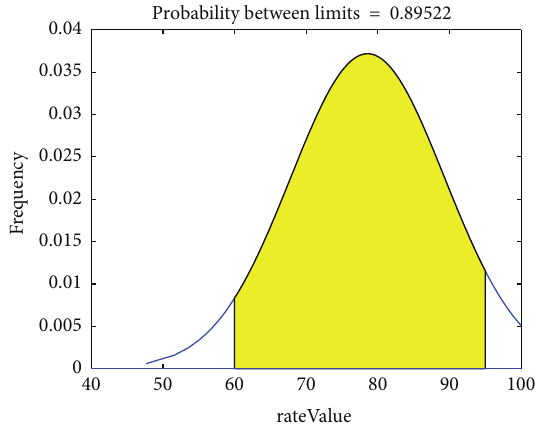
Figure 3: Distribution of a service’s rateScore given by consumers.